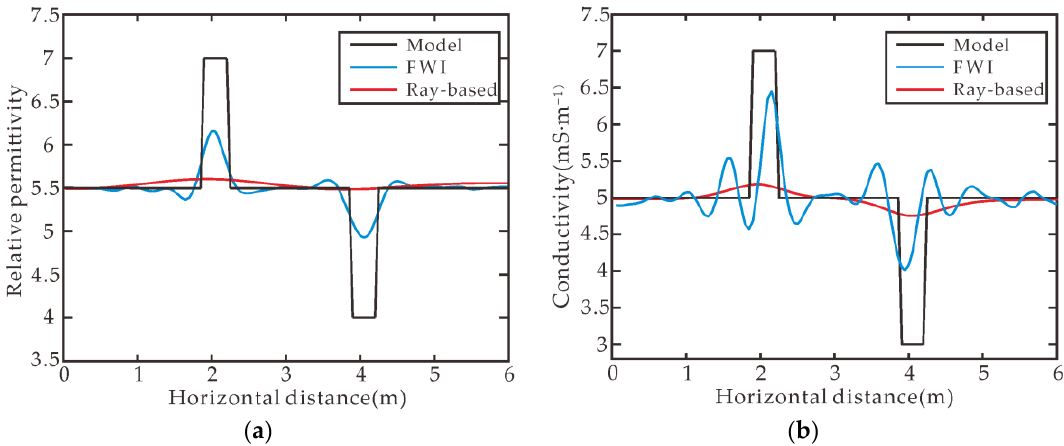
Figure 3. Comparisons among the inverted results from FWI, ray-based, and the true model: ( a ) relative permittivity and ( b ) conductivity along the line from the 1st transmitter position to the 13th receiver position.